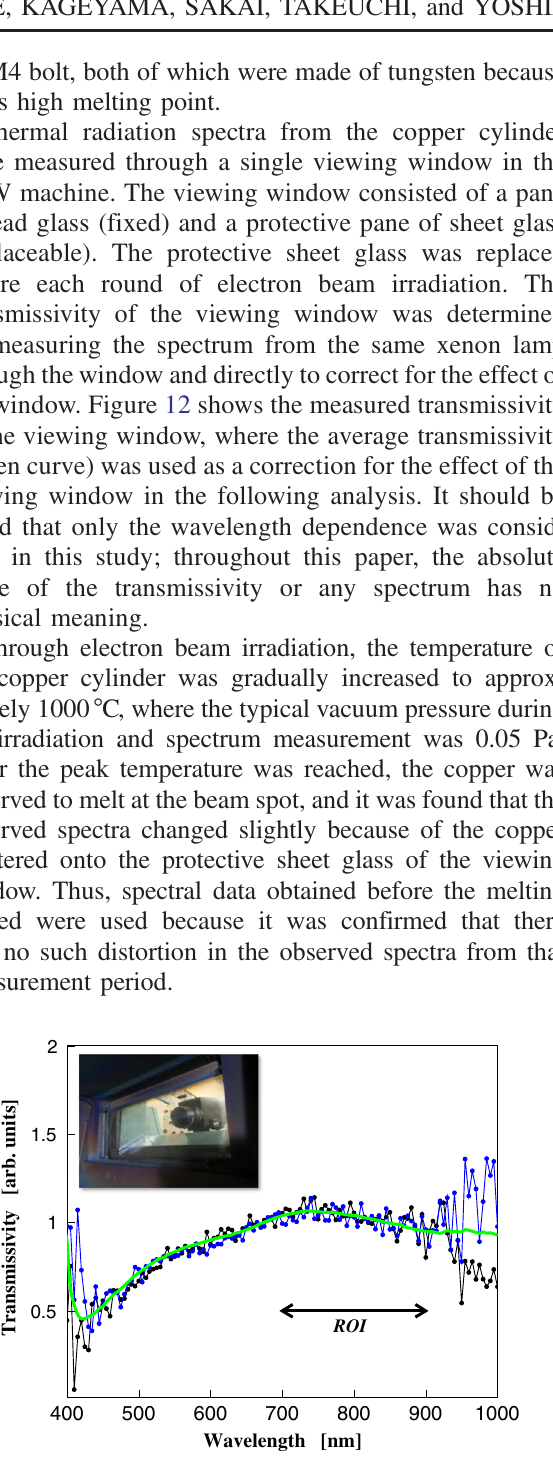
FIG. 12. Transmissivity of the viewing window of the EBW machine. The blue and black points indicate the transmissivity measured at the central pixel of the image sensor and another pixel, respectively. The green curve indicates the transmissivity averaged over all pixels within a central region with an area equal to one quarter of the total area. The top-left inset is a photograph of the hyperspectral camera taken from the inside of the EBW machine through the viewing window. The region labeled ROI indicates the region of interest used to derive physical spectra.